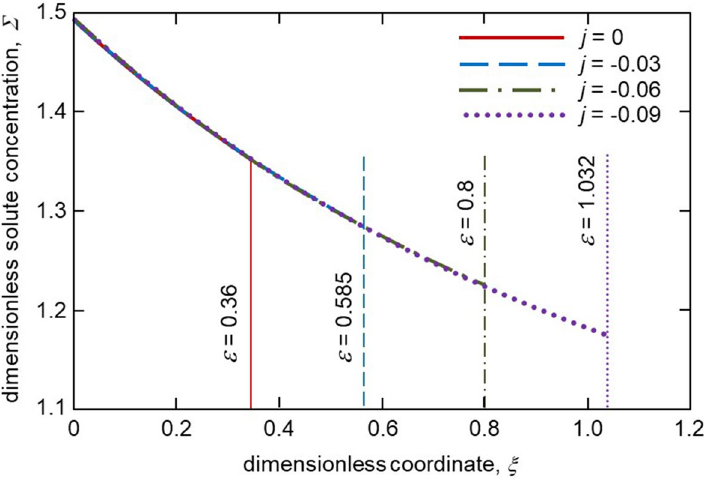
Figure 4. The solute concentration (cid:31) as a function of spatial coordinate ξ in the two-phase layer for various melt fluxes j . Vertical lines show dimensionless thicknesses of the two-phase layer for various j .